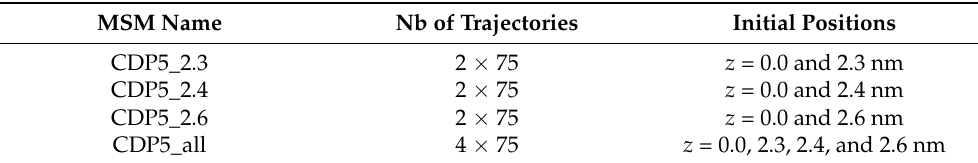
Table 2. Markov State Models built from four different sets of 100 ns unconstrained trajectories of the peptide-membrane